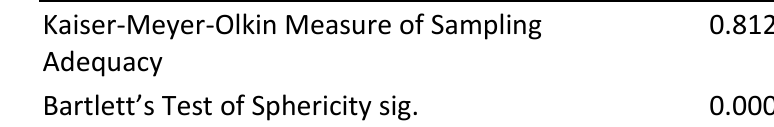
Table 3: Kaiser-Meyer-Olkin and Bartlett’s test results concerning the second stage of the research.